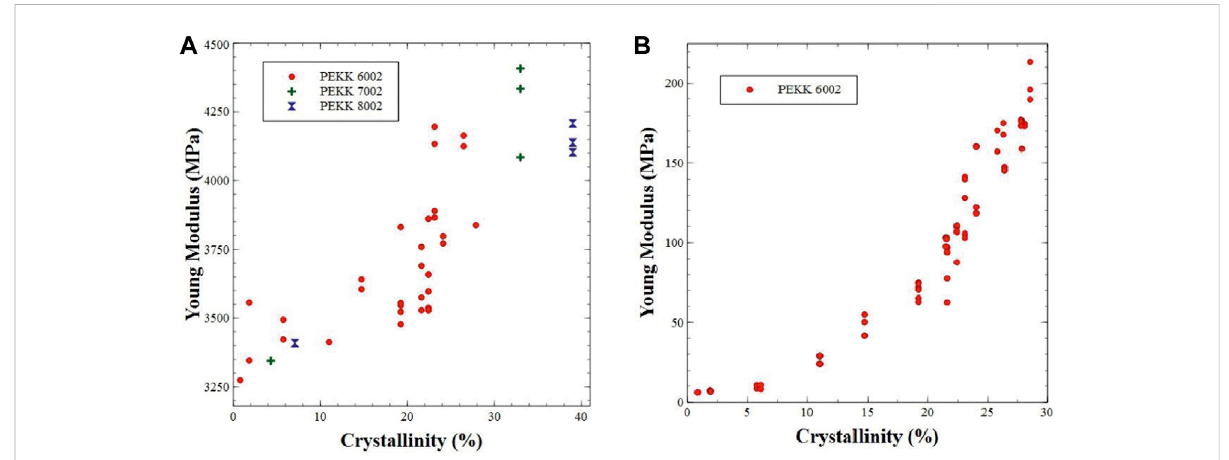
FIGURE 3 Young ’ s modulus against crystallinity degree for PEKK (Choupin, 2017) (A) T = Tamb (B) T = 180 ° C ( > Tg).